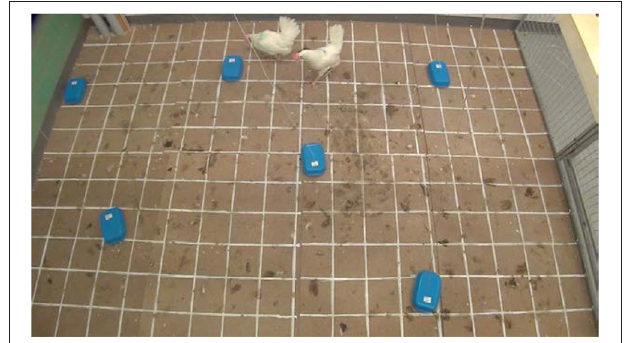
FIGURE 1 | The arena where the social cognition feeding test was carried out. Six bowls with lids that could be opened from the outside were placed on the